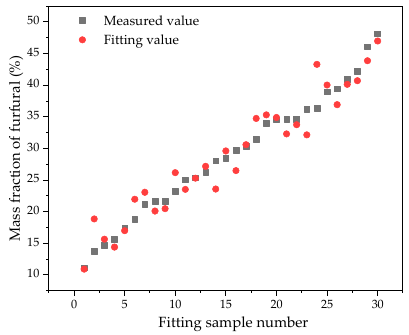
Figure 12. The fitting results of the model of furfural equilibrium distribution. Table 5. The goodness of fit of furfural equilibrium distribution model.